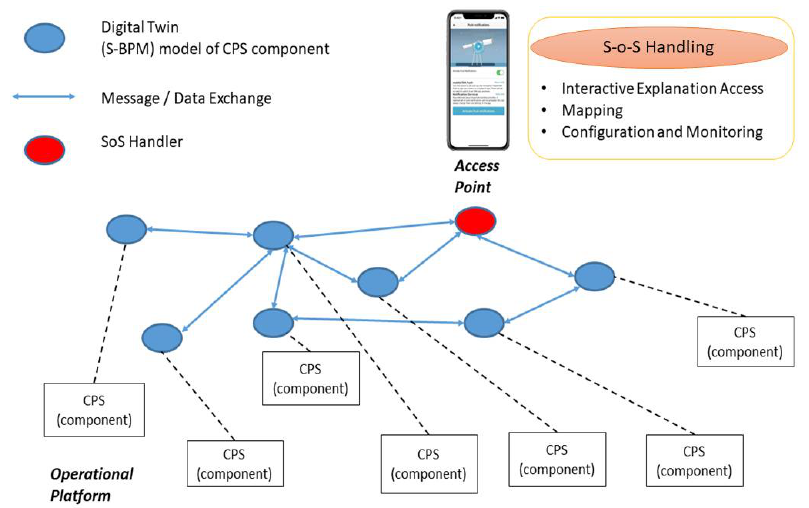
Figure 3. SoS design thinking for governing a CPS.